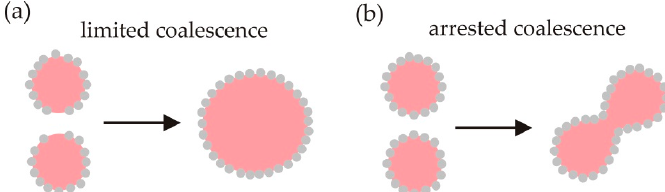
Figure 5. Pickering emulsions destabilise by ( a ) limited coalescence until a critical surface coverage of particles is reached if there are not sufficient particles present to fully coat all the drop surfaces that form initially; and by ( b ) arrested coalescence where the combined surface area occupied by particles is higher than the interfacial area that would form by complete coalescence of the drops, so the coalescing drops remain trapped in an intermediate stage of coalescence, unable to relax into a spherical